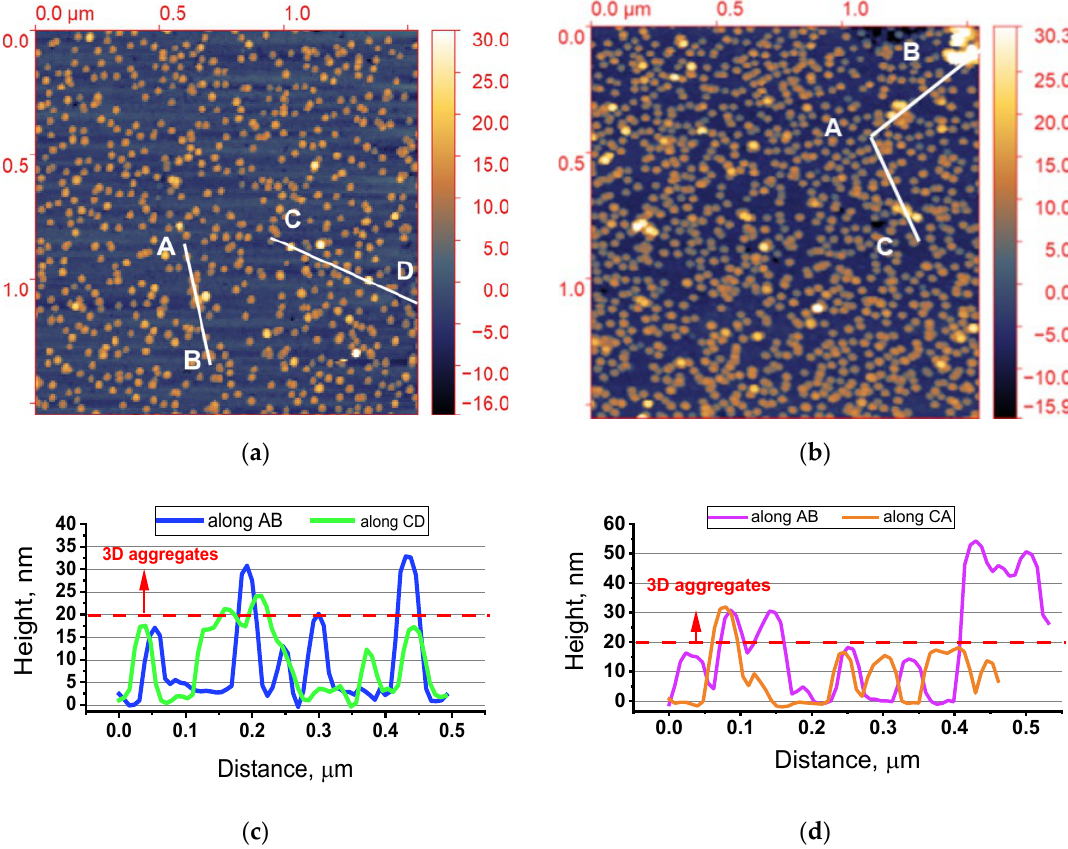
Figure 1. AFM images (1.54 × 1.54 μm 2 ) of the Si wafer surface of ( a ) S30 and ( b ) S30/20 with corresponding profiles of cross-sections along A–B, C–D shown in ( c ) and along A–B–C shown in ( d ). Each single round spot with a similar color profile corresponds to a single AuNP, while not-uniform objects or the ones with brighter contrast correspond to AuNP agglomerates.